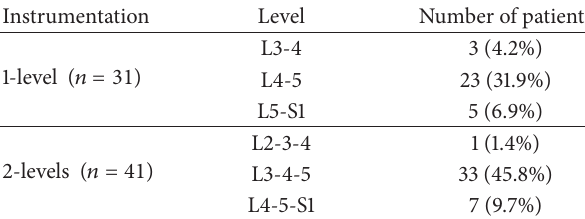
Table 2: Distribution of treated levels.